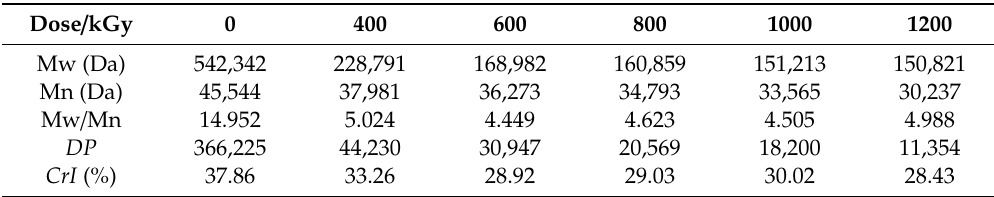
Figure 1. E ff ect of absorbed dose on reducing sugars yield and methylene blue adsorption. Table 3. Influence of absorbed doses on molecular weight distribution, DP , and CrI of Miscanthus